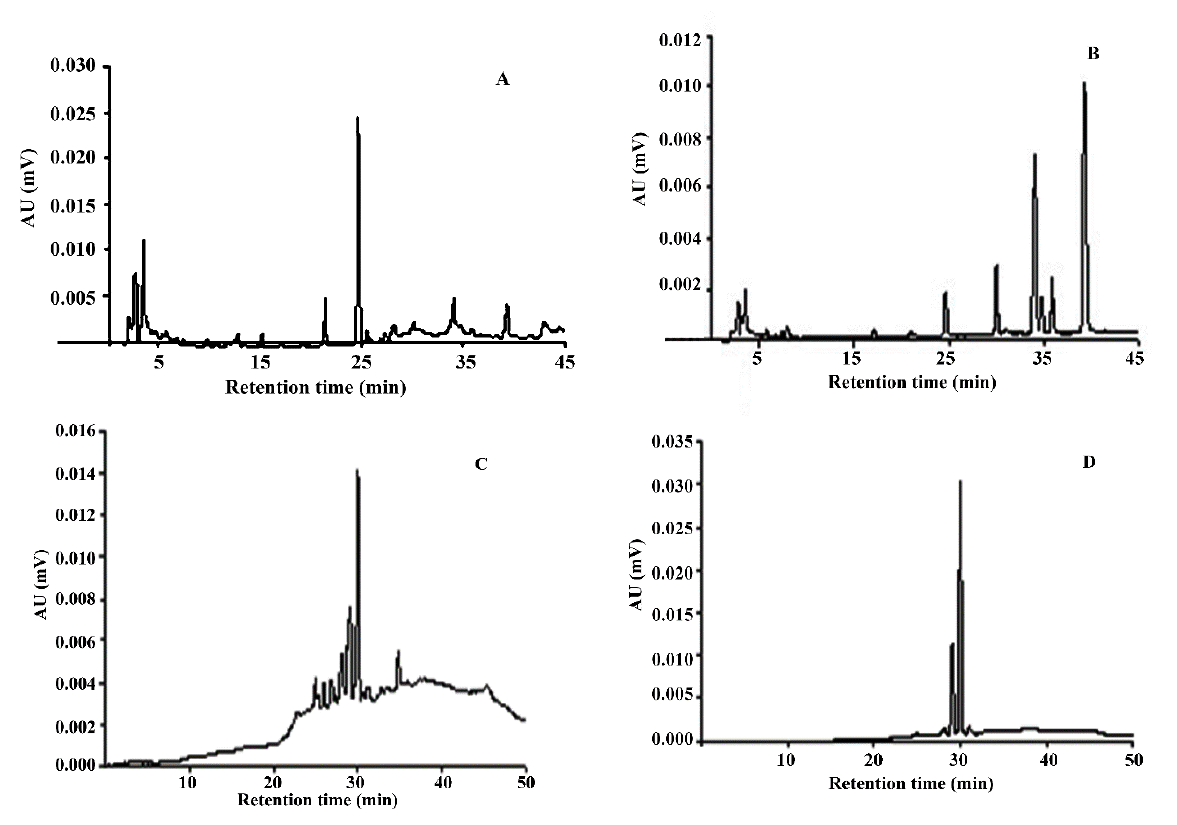
Figure 3. Chromatogram of P. carthagenensis ( A ), P. capillacea ( B ), P. leiocarpa ( C ) and P. deflexa ( D ) extracts by HPLC/PDA